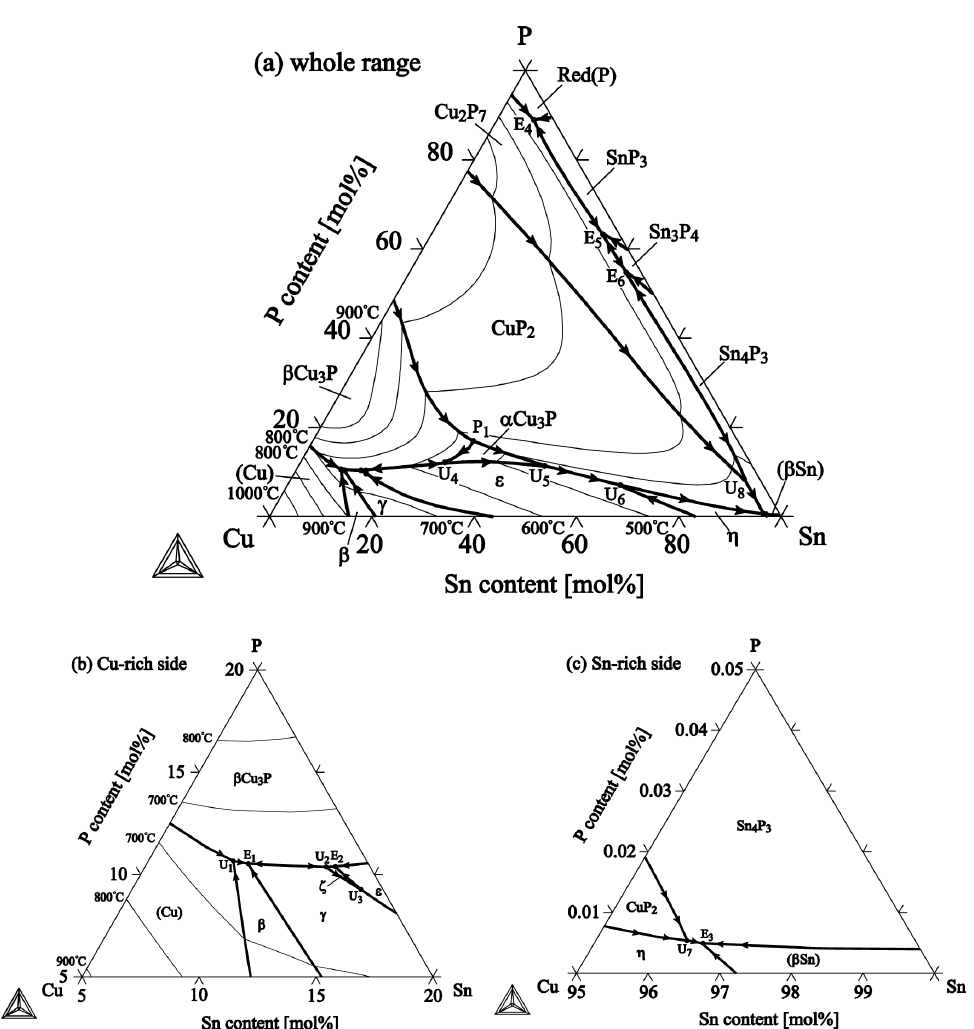
Figure 10. The calculated liquidus surface projection of (a) whole range of Cu-Sn-P system, and enlarged projections on (b) Cu-rich side and (c) Sn-rich